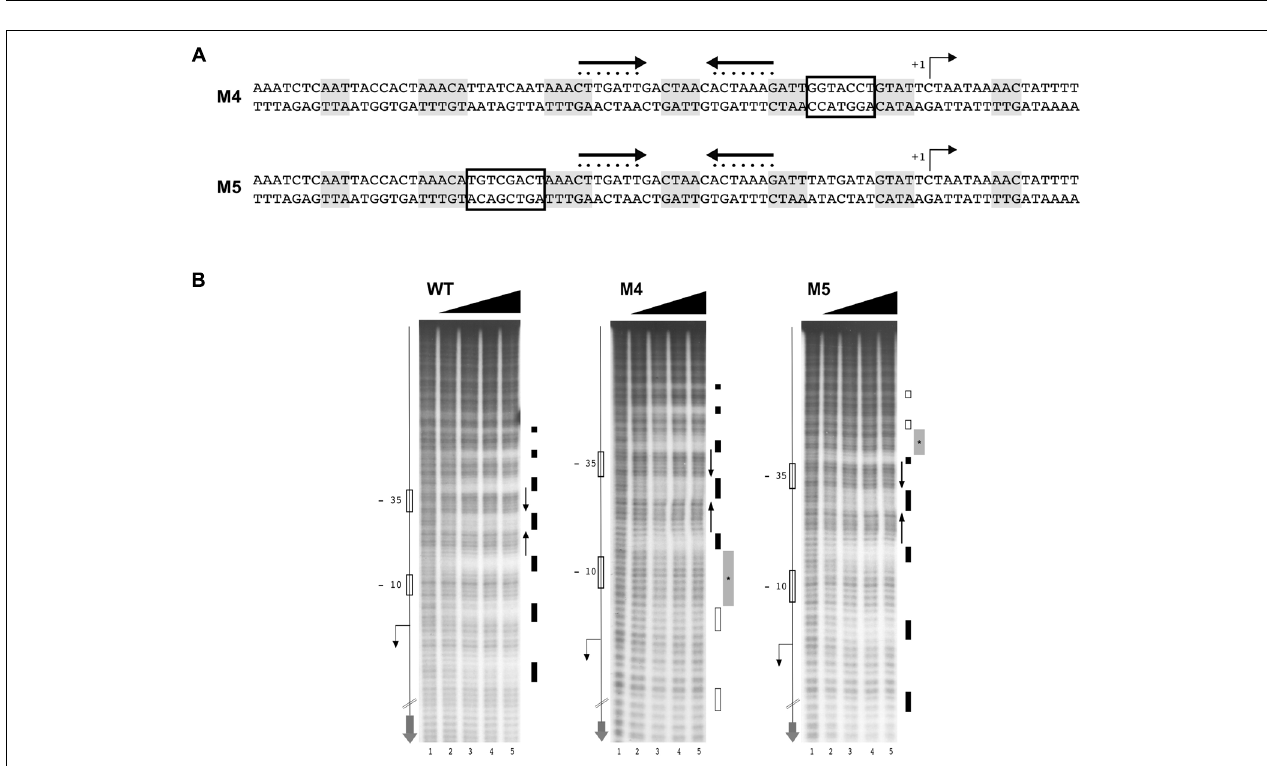
FIGURE 6 | Non-conserved regions surrounding the HAIR-motif are required for HspR binding. (A) Schematic representation of WT and two P cbp mutant probes, in which the spacer regions highlighted with empty boxes were mutagenized by base substitution. Symbols are as in the legend to Figure 3 . (B) From left to right, hydroxyl-radical footprint experiments on WT and mutant probes described in (A) (M4 and M5) with increasing amounts of purified HspR protein detailed in the legend to Figure 3 .